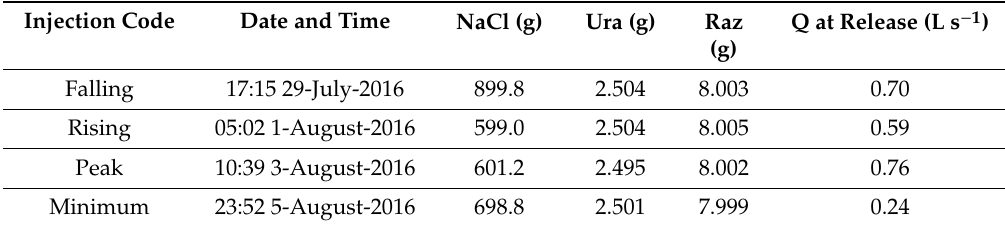
Table 1. Summary of tracer